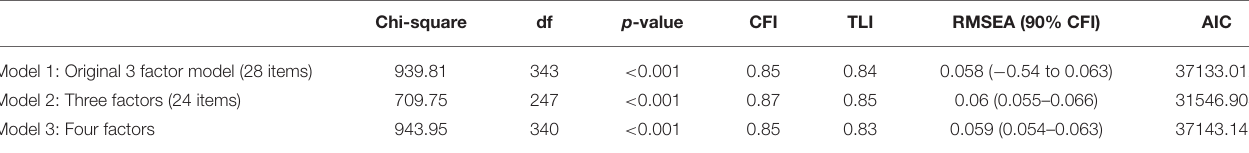
TABLE 2 | Fit indices of the compared models. Chi-square df p -value CFI